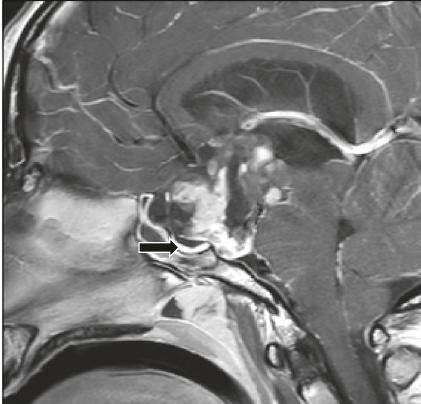
(a) Axial CT head w/o contrast at the level of the suprasellar cistern showing a mixed cystic and solid mass extra axial mass with peripheral calcifications (arrows) (Figure 1(a))